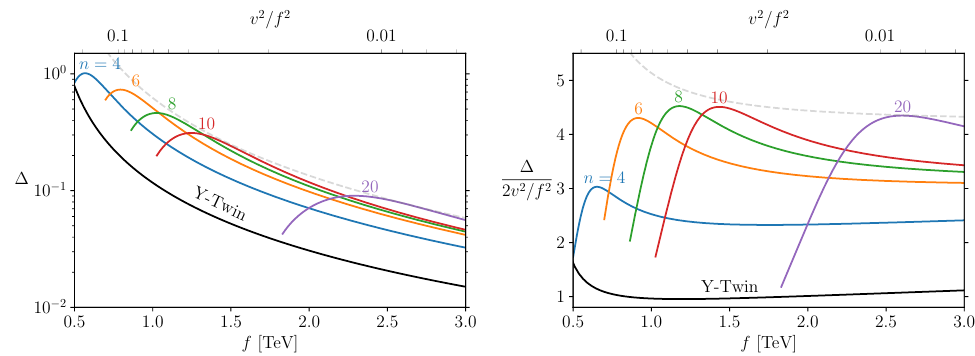
Figure 2 . (Left) Total fine-tuning of Gegenbauer’s Twin for different spurion index n , as a function of the symmetry breaking scale f . For comparison, we also show the composite Twin Higgs model of [8] (denoted Y-Twin), where the Z 2 breaking arises from not gauging the Twin hypercharge. The dashed line shows the n -independent ( ∂ log v 2 /∂ log a ) − 1 contribution that dominates the tuning of Gegenbauer’s Twin. (Right) Ratio of the tuning of Gegenbauer’s Twin and Y-Twin models to the naive 2 v 2 /f 2 estimate expected for the